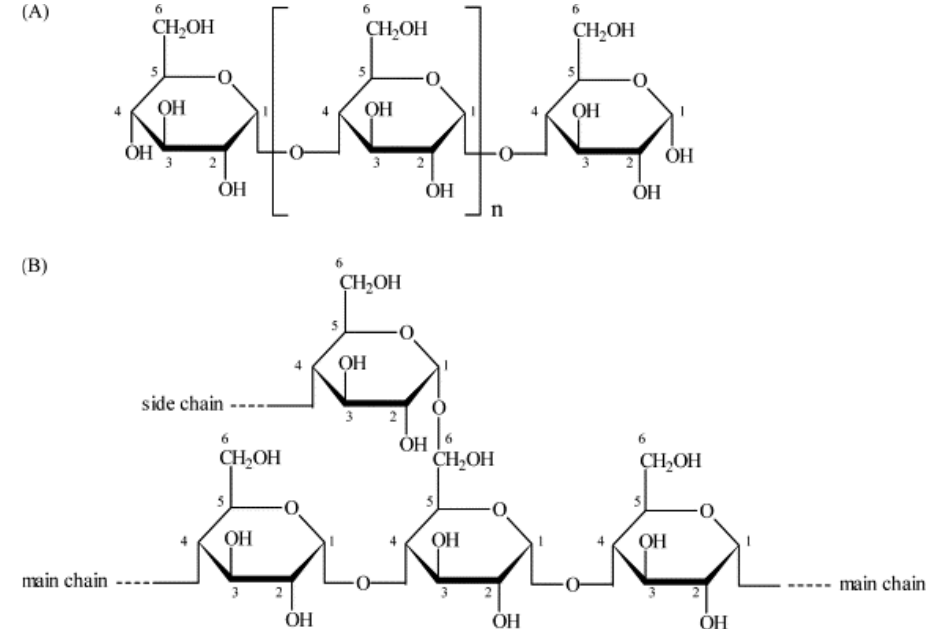
Figure 1. Structure of starch amylose ( A ) and amylopectin ( B ) (adapted from Herrero-Martínez et al.